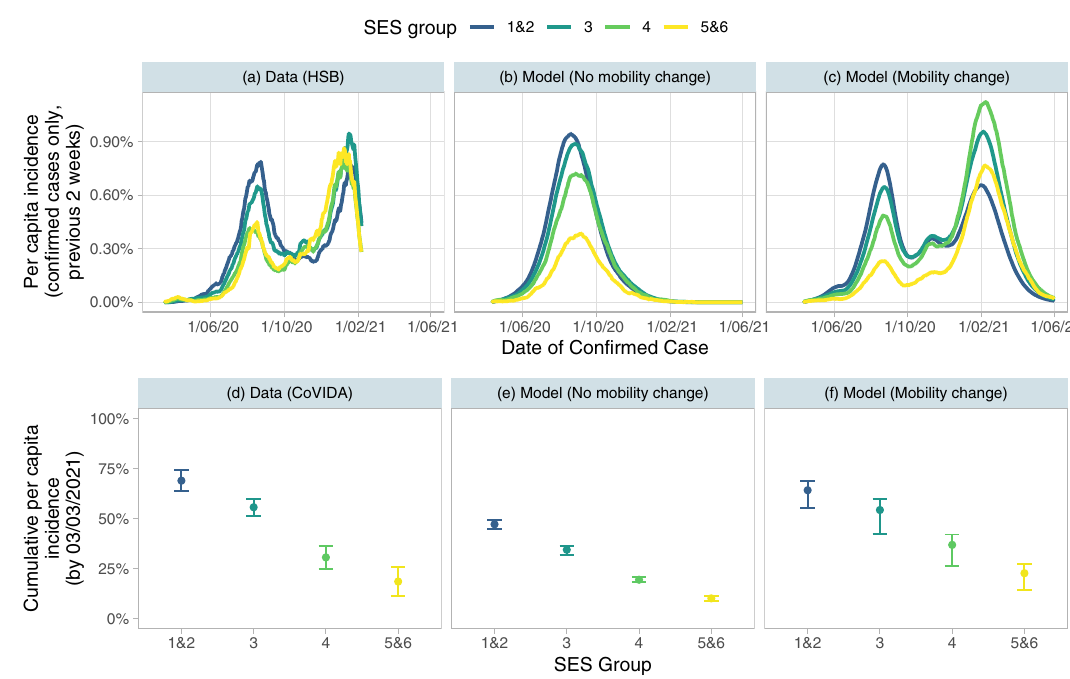
Figure 2. Estimations of incidence rate using data and baseline simulations. Panels ( a ), ( b ), and ( c ) show the per capita incidence over the previous 2 weeks based on confirmed cases (those who test positive) for each SES at each date. Panel ( a ) is based on the administrative data from the HSB on the number of confirmed cases at each date. Panel ( b ) is calculated using the number of infected individuals that test positive in the model simulation with no mobility change, while panel ( c ) uses the same calculation for the model simulation that allows for mobility to change over the course of the epidemic (in a way that best predicts total detected cases). Panels ( d ), ( e ) and ( f ) show the cumulative per capita incidence (including both confirmed and unconfirmed cases) by the 3rd March 2021 (the most recent date for which the CoVIDA data is available). Panel ( d ) uses positivity in CoVIDA data to calculate incidence, see Section S1.1. Panel ( e ) and ( f ) includes all infections in the versions of the model without and with mobility change respectively. All model results are calculated by taking the median value over 50 simulations. Model and actual dates are aligned by taking the model time period for which the model-predicted 2 week total per capita incidence is the same as the actual value on June 1st 2020, and setting this time period to be June 1st